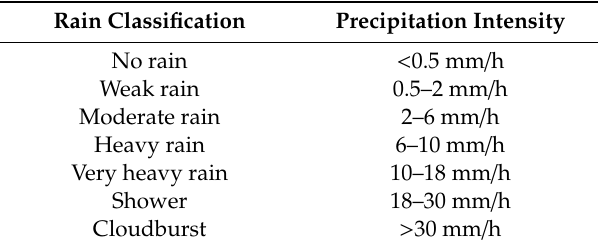
Table 1. Rain classification and precipitation intensity